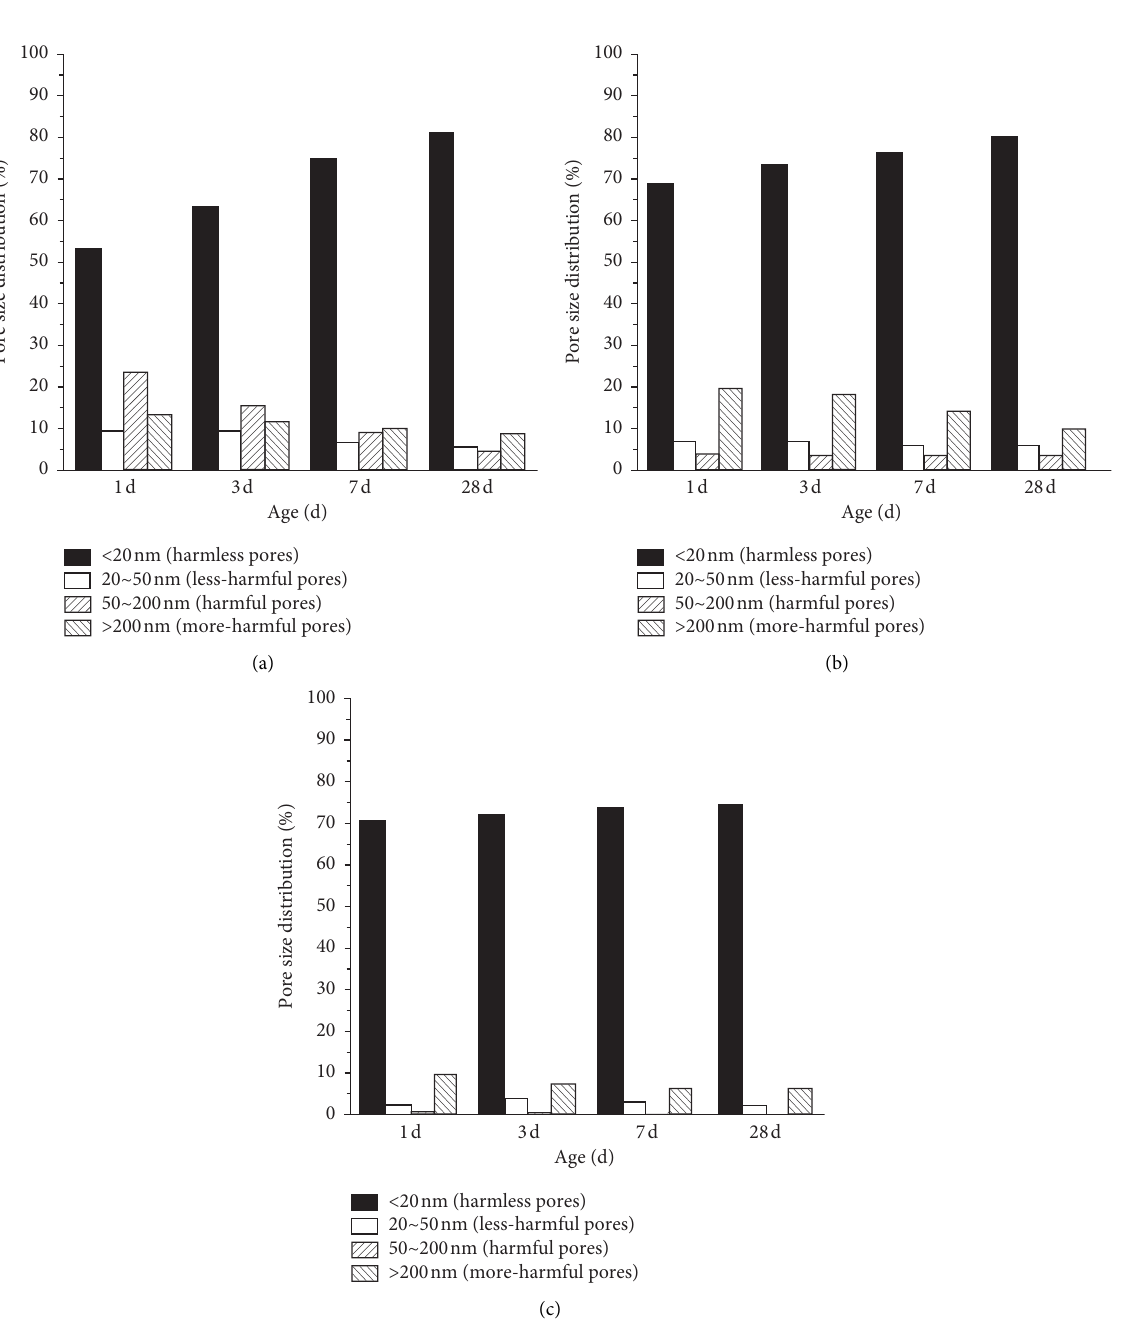
Figure 10: The pore size distribution of alkali-activated nickel slags activated by different types of the alkali activator. (a) NS13-N2-J1. (b) NH8.52. (c)